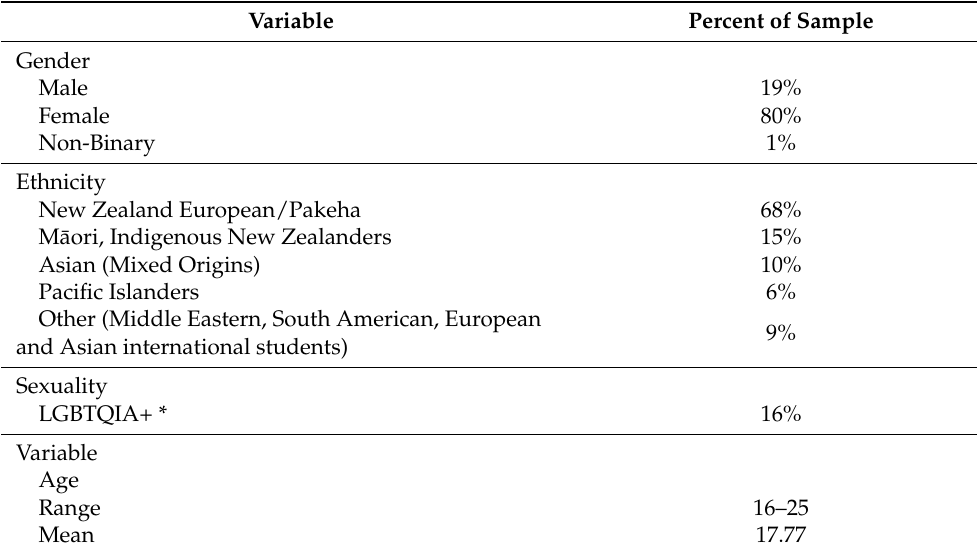
Table 1. Participant